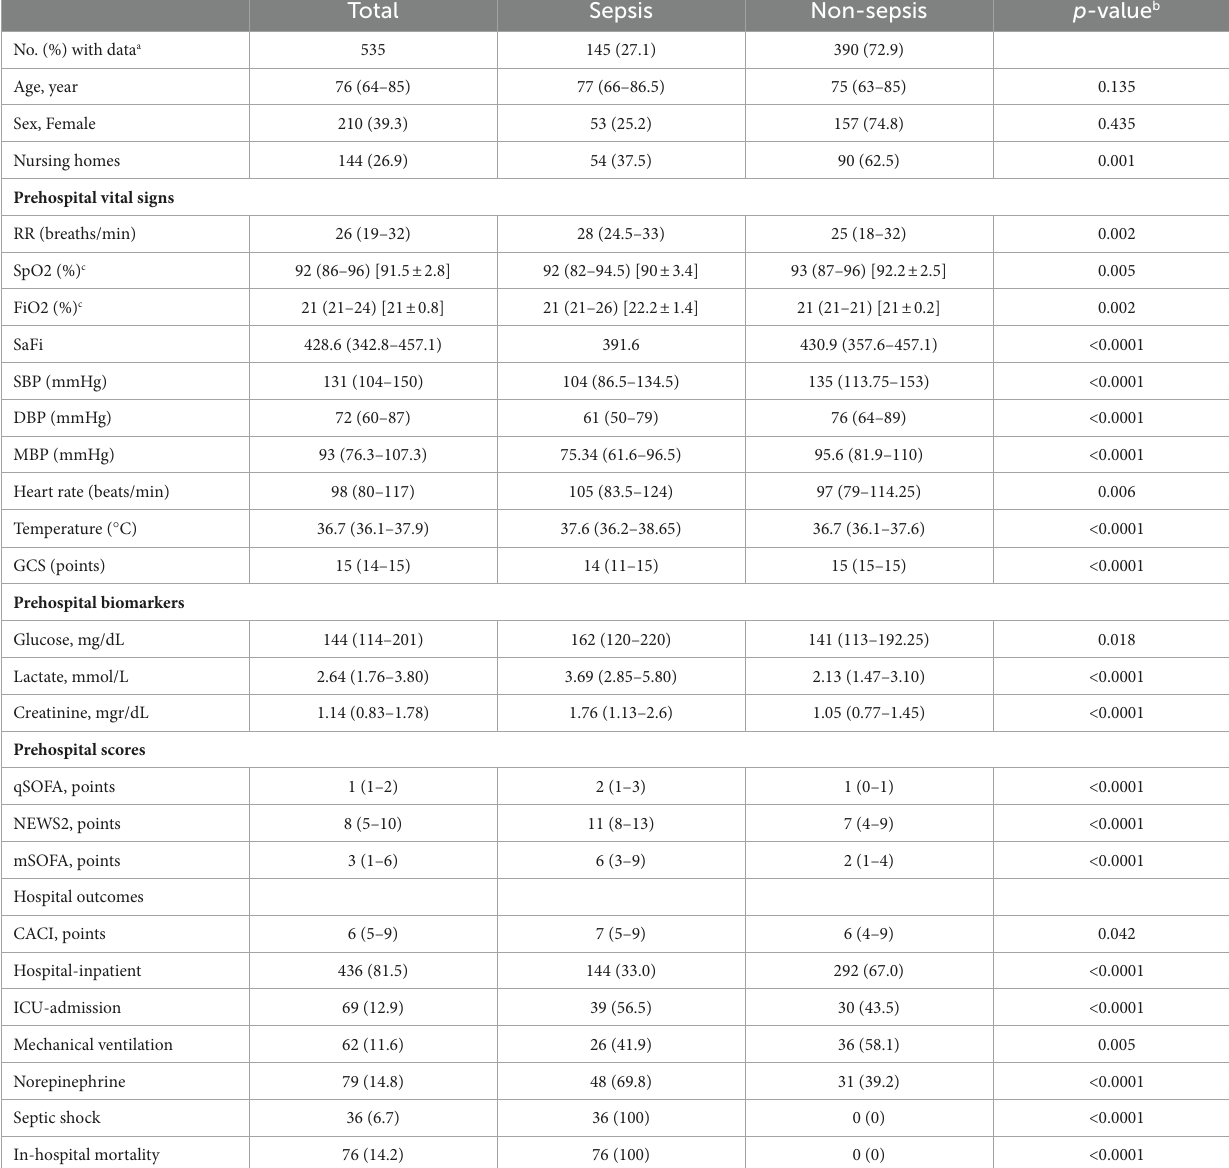
TABLE 1 Baseline patients’ characteristics according sepsis vs. non-sepsis cases. Total Sepsis Non-sepsis p- value b